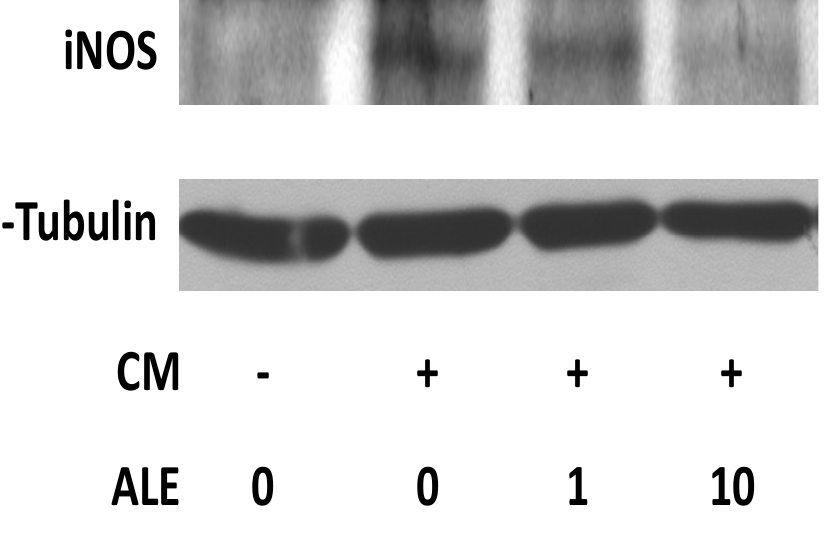
Figure 2. Artichoke leaf extracts downregulate iNOS protein expression. Human coronary artery smooth muscle cells were treated with the cytokine mixture (CM) or CM in combination with an artichoke leaf extract (ALE, µg/mL) for 24 h. Western blot analyses were performed with a monoclonal anti-iNOS-antibody (top) or a monoclonal antibody to β -tubulin (bottom, for normalization). The blots shown are representative of three independent experiments with similar